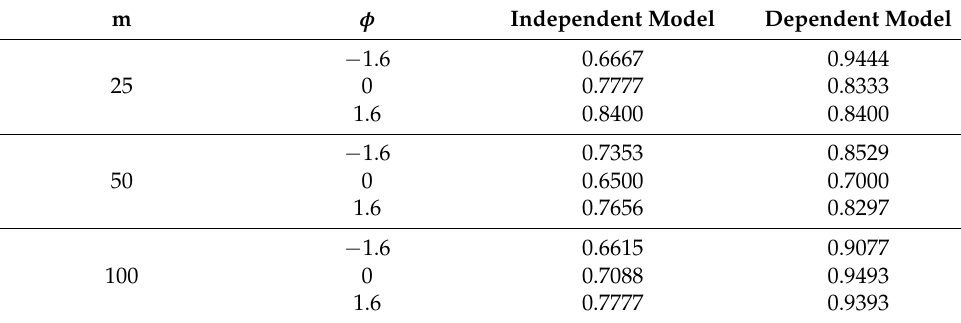
Table 1. Proportion of S lying in its respective PIs.